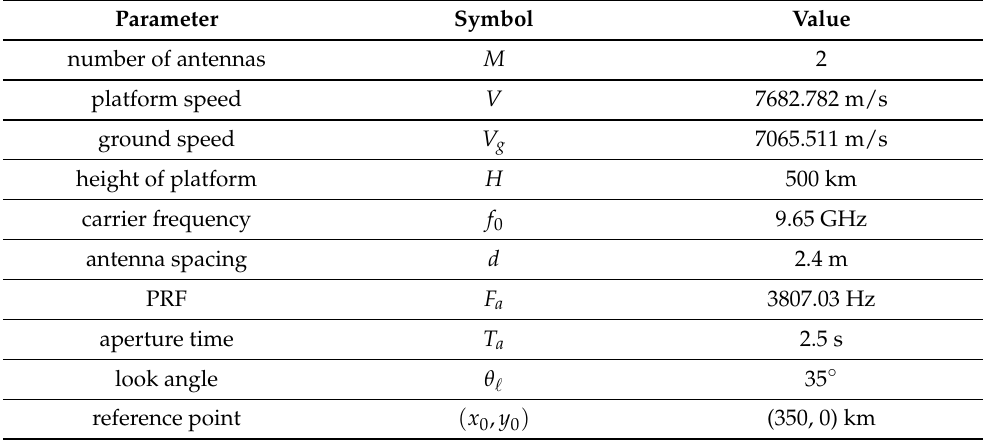
Table 5. Parameters in real data experiment [34].